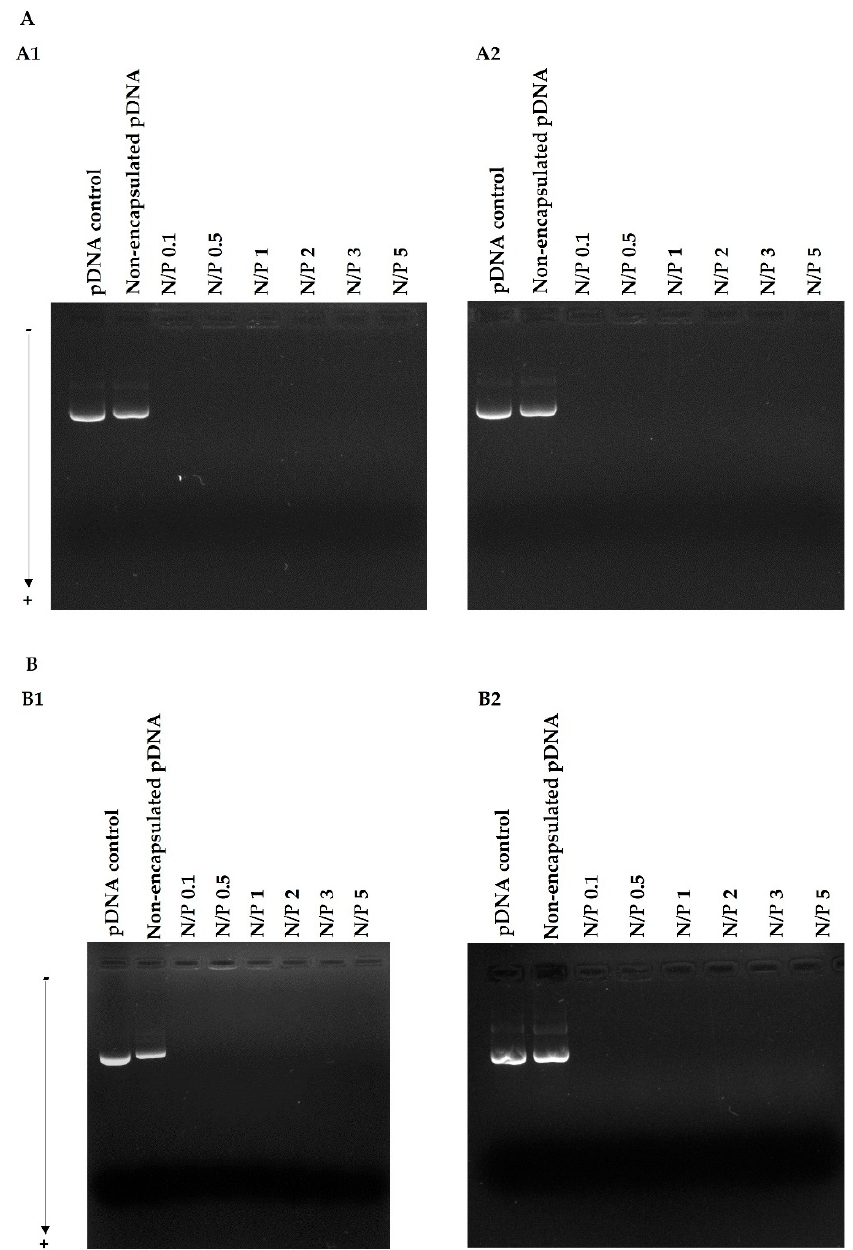
Figure 4. Electrophoretic analysis of WRAP5/pDNA ( A ) and Tf-WRAP5/pDNA complexes ( B ) for- mulated at different ratios after 4 h of incubation with DMEM/Nutrient Mixture F-12 Ham (DMEM/F-12) with L-glutamine (1) and DMEM high glucose with stable glutamine medium (2). Lane 1: pDNA control and lane 2: non-encapsulated pDNA. Complexes were loaded on the agarose gel without a centrifugation step (see Scheme S1B).